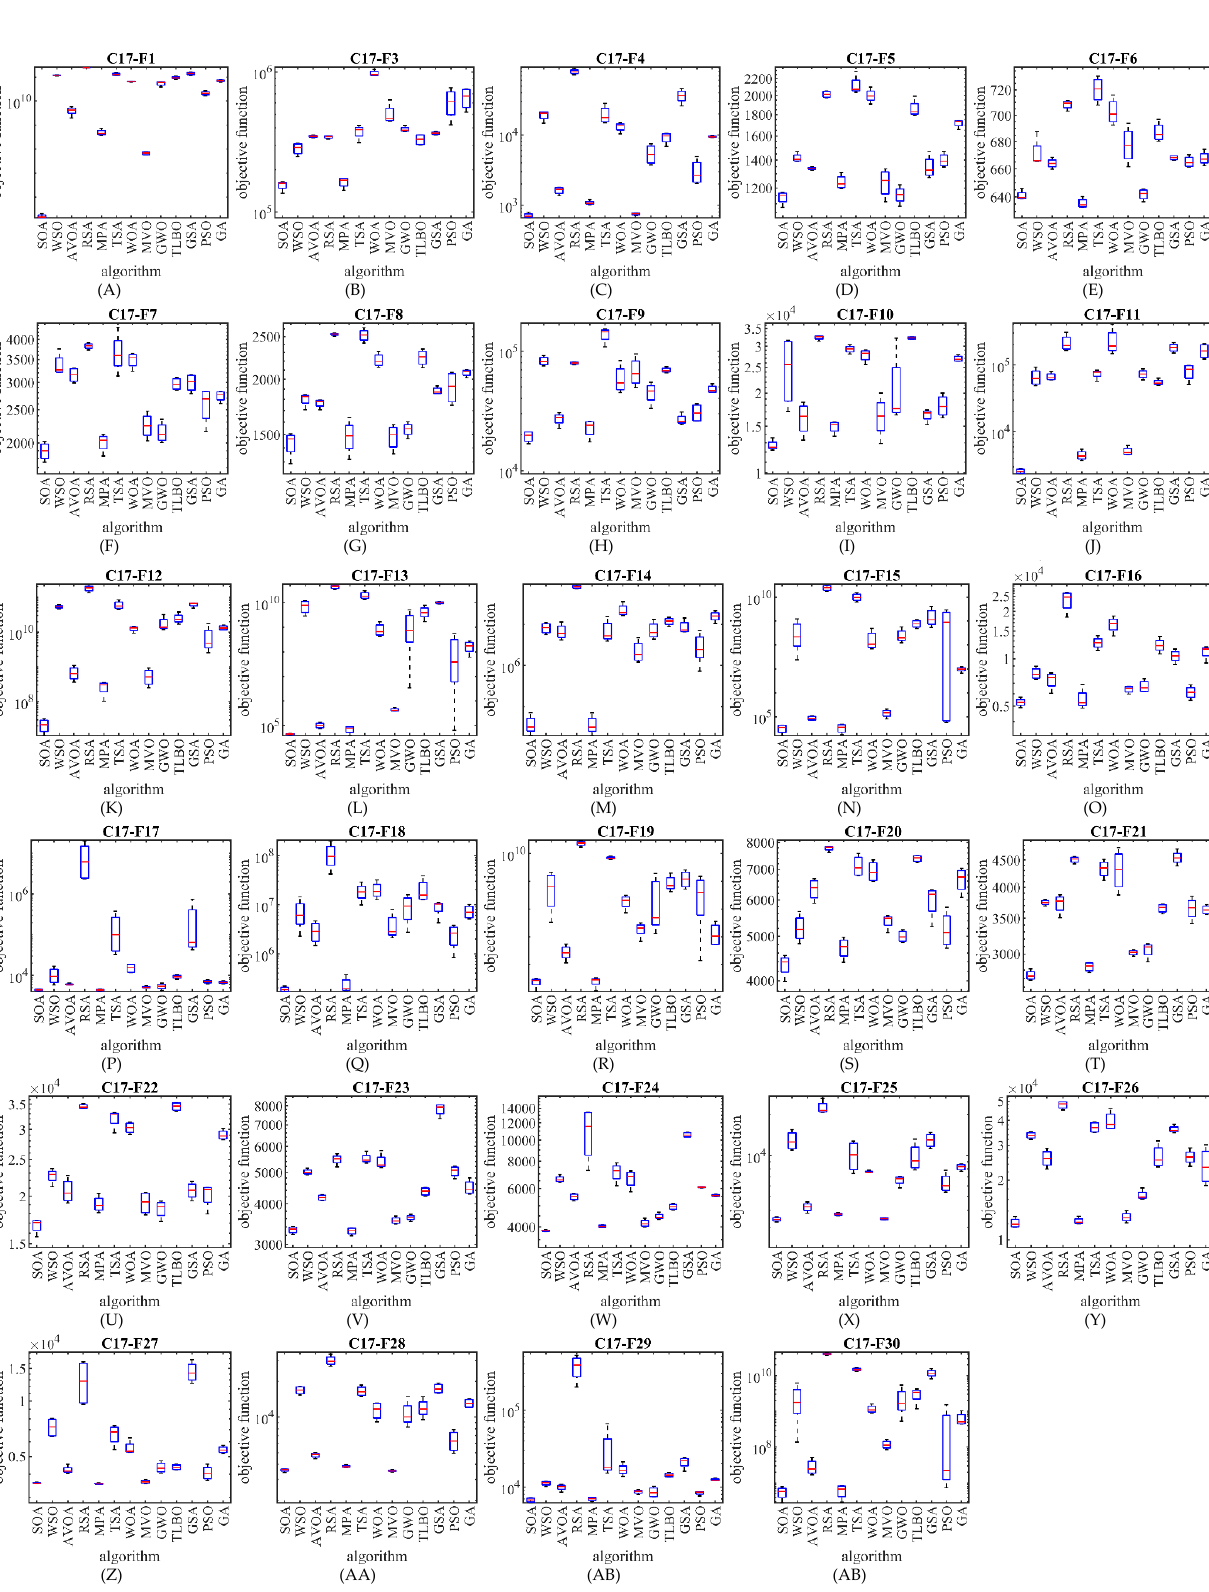
Figure 5. Boxplot diagram of SOA and competitor algorithms performances on the CEC 2017 test suite (for the dimension 𝑑 = 100 ).